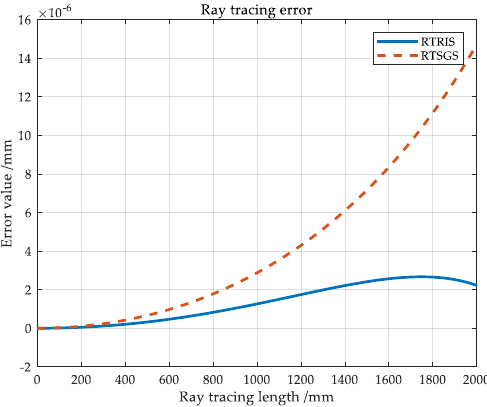
Figure 3. Ray tracing error example 1.